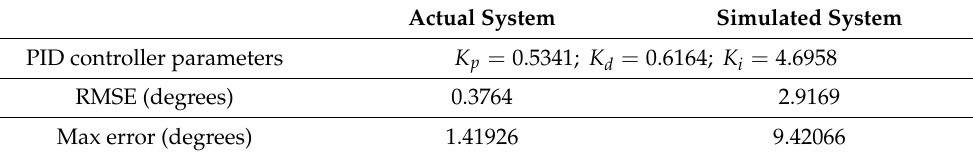
Figure 10. Dual PAM pressure output of PID simulation parameters applied to real system. Table 4. Comparison table of PID controllers for actual and simulated systems.